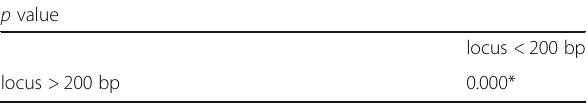
Table 2 Comparison in success analysis of loci length above and below 200 bp using Willcoxon Signed Rank